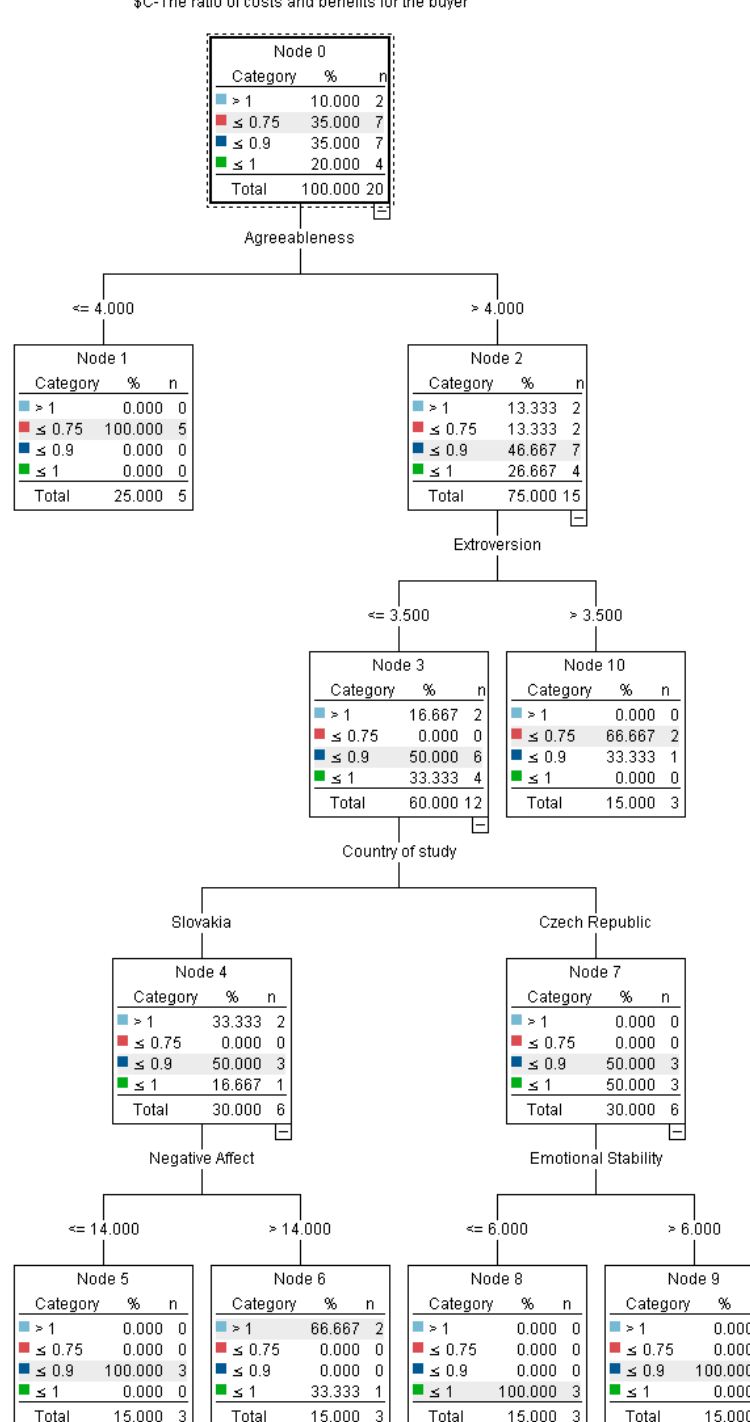
Figure A2. Decision tree for buyer.